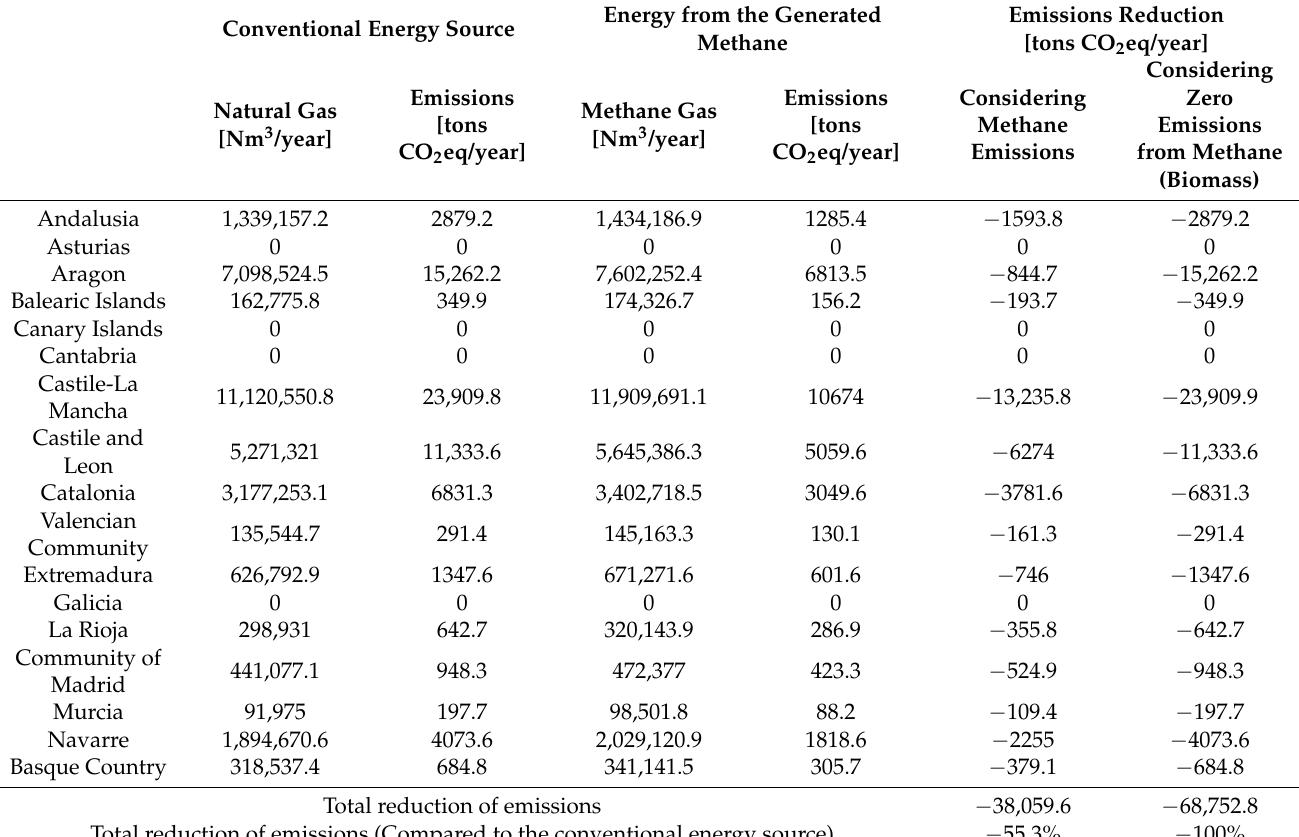
Table 9. Estimation of the biogas and methane generated with the anaerobic digestion of